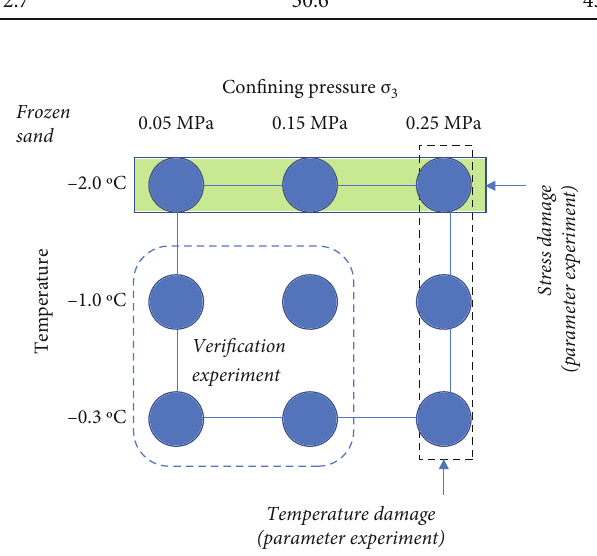
Particle composition (%) > 0.5mm